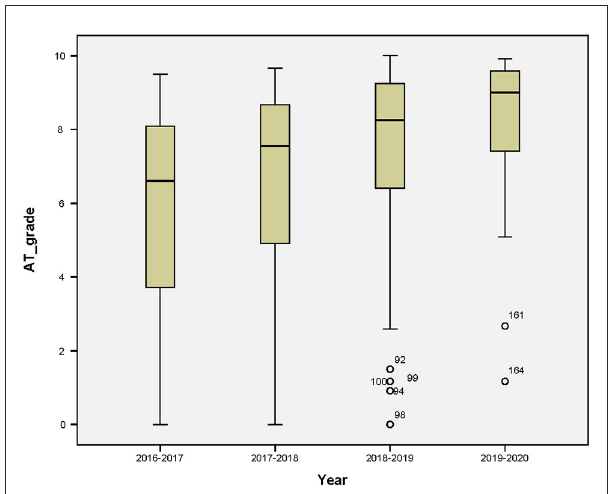
FIGURE2 Boxplots of all data collected from 2016 until 2020 from students of several undergraduate degrees.